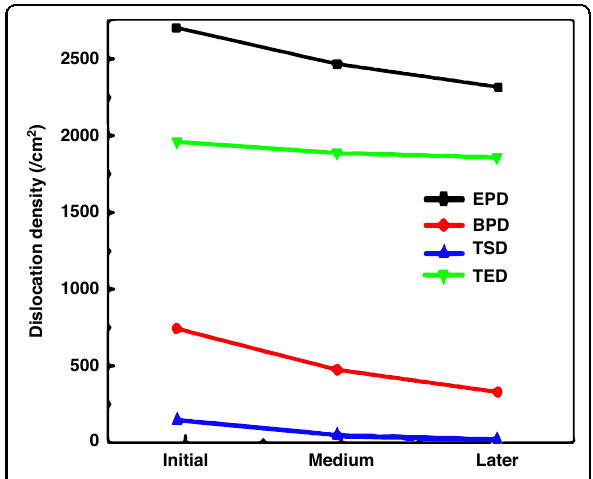
Fig. 5 The dislocation density in the different stage of